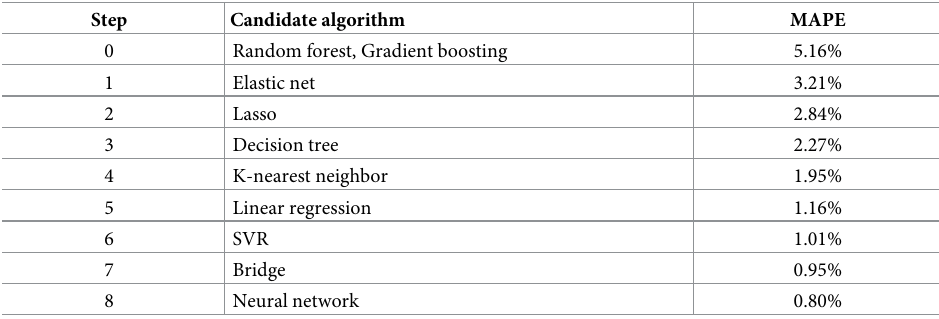
Table 2. Forward selection of candidate